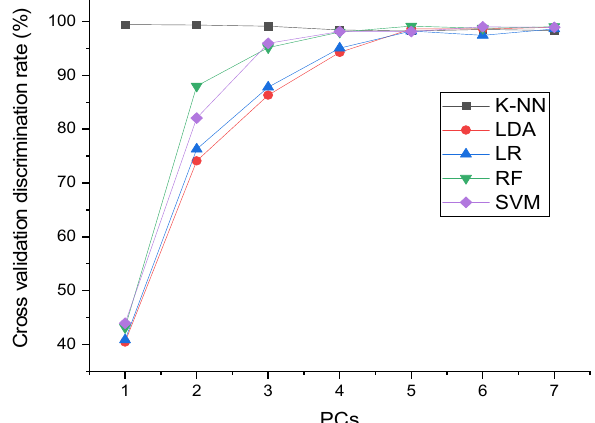
Figure 5. Cross-validation discrimination rates of different models at different PCs. K-NN: K-Nearest Neighbor; LDA: Linear Discriminant Analysis; LR: Logistic Regression; RF: Random Forest; SVM; Support Vector Machine.